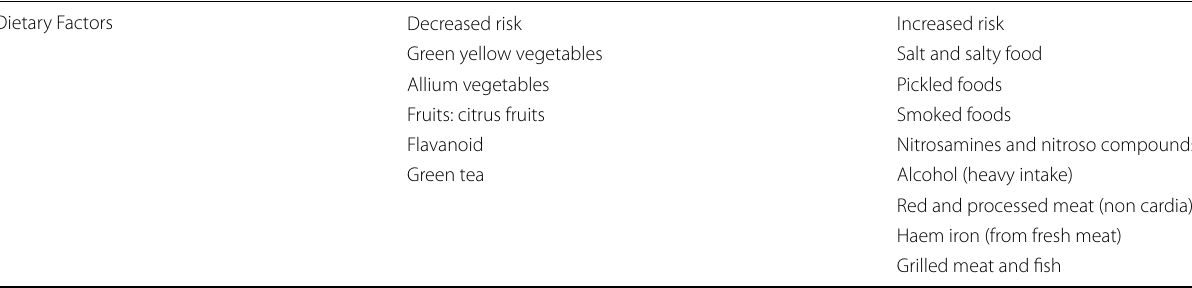
Table 1 Dietary factors associated with gastric cancer risk [3] Dietary